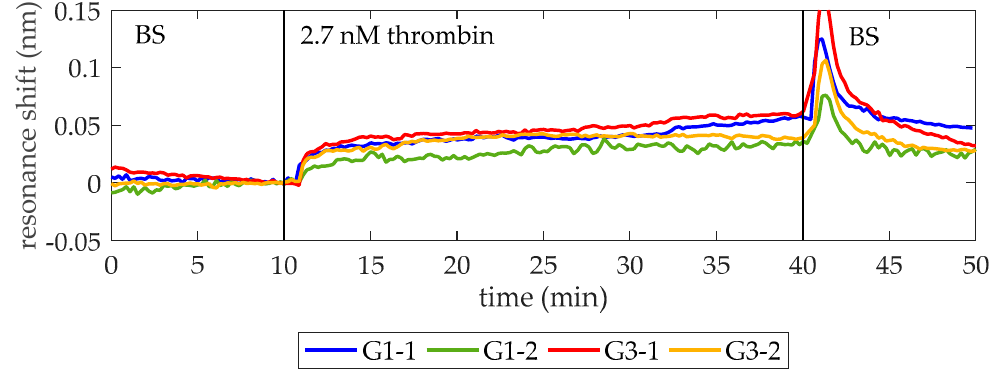
Figure 6. Sensing response of the PC-sensing structures when a 2.7 nM thrombin solution is flowed. At minute 10, 2.7 nM thrombin solution in BS is flowed (it reaches the photonic chip one minute later) and its binding to TBA on the surface is clearly observed. At minute 40, BS is flowed again to remove the excess of thrombin. The sudden peak observed is a RI increase due to different densities of the two solutions being exchanged in the fluidic chamber, as previously observed in Figure 5. An average spectral shift of 39 pm and 30 pm is observed for the structures from groups G1 and G3, respectively. Note that now the structure G1-2 corresponds to the 1D PC with w i = 100 nm from group G1.